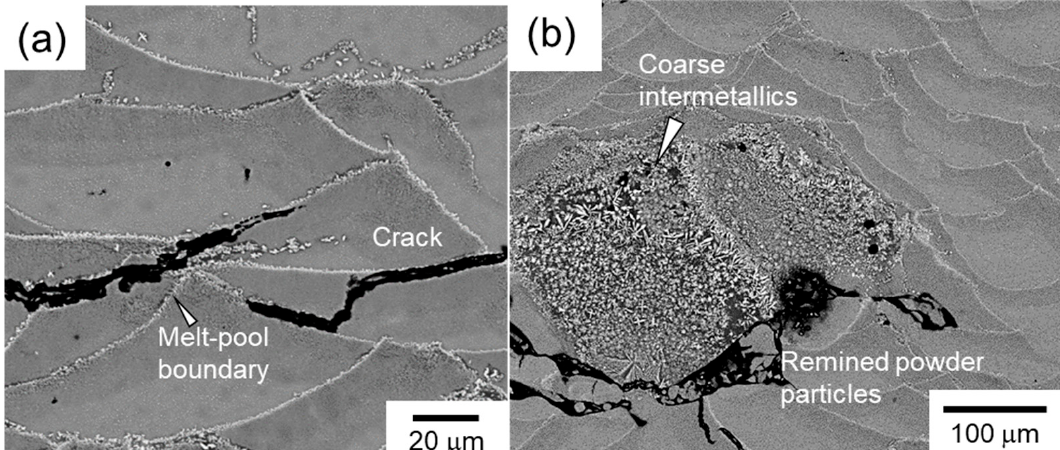
Figure 9. Backscattered electron images showing cracks propagate ( a ) along melt pool boundaries or around the coarsened Al-Fe intermetallic phases ( b ) in L-PBF-manufactured Al–15%Fe alloy sample under 128 W-0.7 m·s –1 .